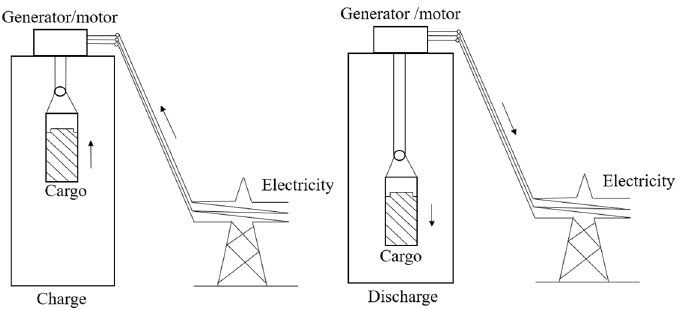
Figure 4. Gravitational energy storage system.